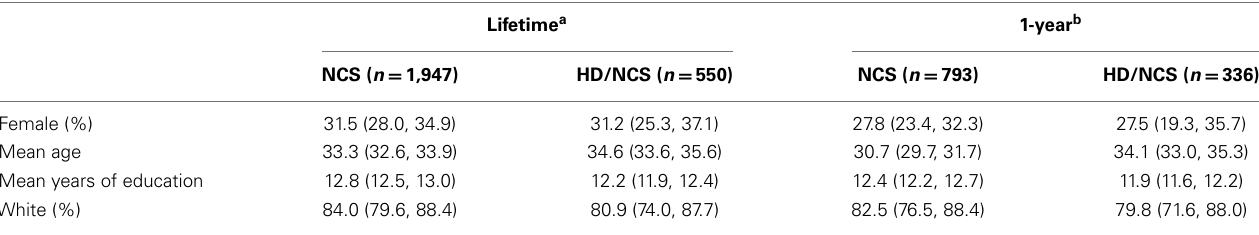
Table 1 | Means and percentages (95% confidence intervals) for demographic variables of lifetime and 1-year alcohol disorders, ages 18–54, N = 7,599